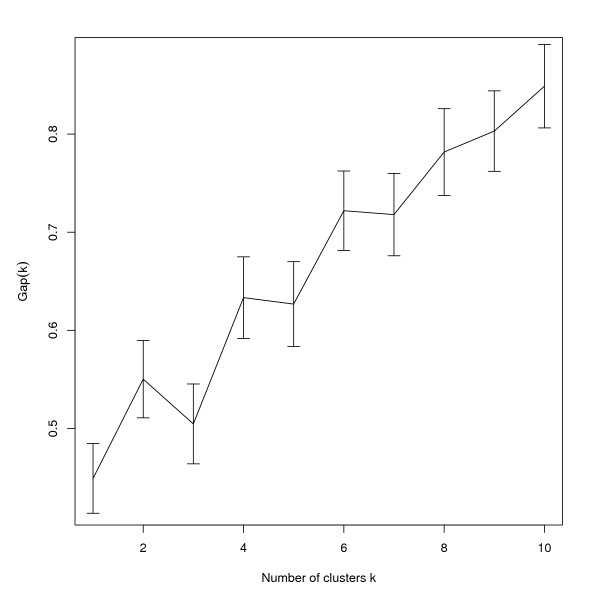
Estimation of optimal cluster number by gap-stat analysis. The gap statistic for the hierarchical clustering of the genes analyzed by RT-PCR. The within-cluster dispersion (an error measure) decreases monotonically as the number of clusters increases. If the data do tend to form a certain number of clusters, say k, then the decrease in the within-cluster dispersion will flatten markedly thereafter. The gap statistic calculates the value(s) of k at which this happens in order to estimate the optimal number of clusters [15]. In the RT-PCR data, two well separated clusters can be identified because of the local maximum at k = 2. However, the gap function rises again with a strong increase at k = 4 and k = 6, suggesting the existence of less well separated clusters within the main clusters.